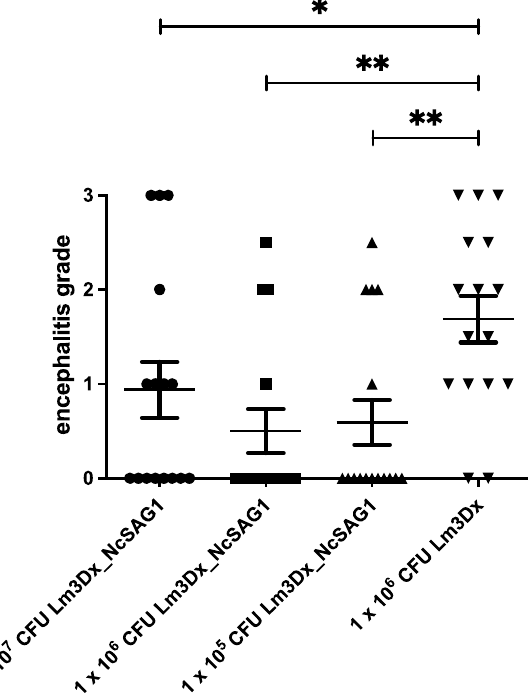
Figure 7. Scoring of encephalitis grades after brain samples were formalin-fixed, paraffin embedded, cut at 4 µ m and stained with HE. Cerebral parasite load and associated lesions were assessed by microscopical analysis. Encephalitis grades were analyzed between groups by the non-parametric Kruskal–Wallis test. Every group was compared with the positive control group by using the Mann–Whitney-U test (* p < 0.0495 for 1 × 10 7 CFU Lm3Dx_NcSAG1, ** p < 0.0018 for 1 × 10 6 CFU Lm3Dx_NcSAG1, ** p < 0.0034 for 1 × 10 5 CFU Lm3Dx_NcSAG1).